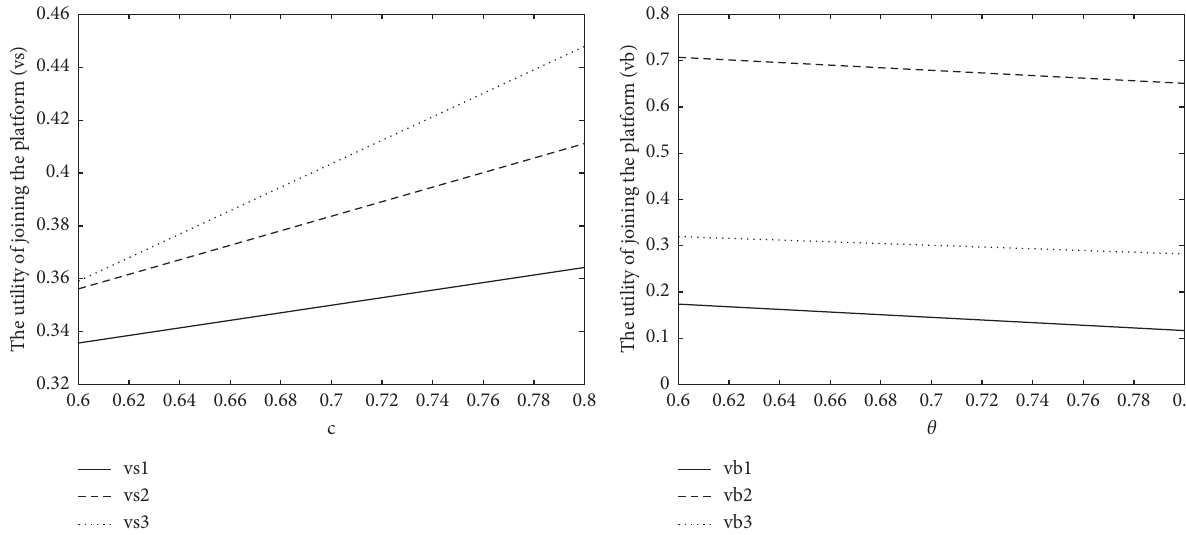
Figure 8: The impact of cost and consumer’s sensitivity on user